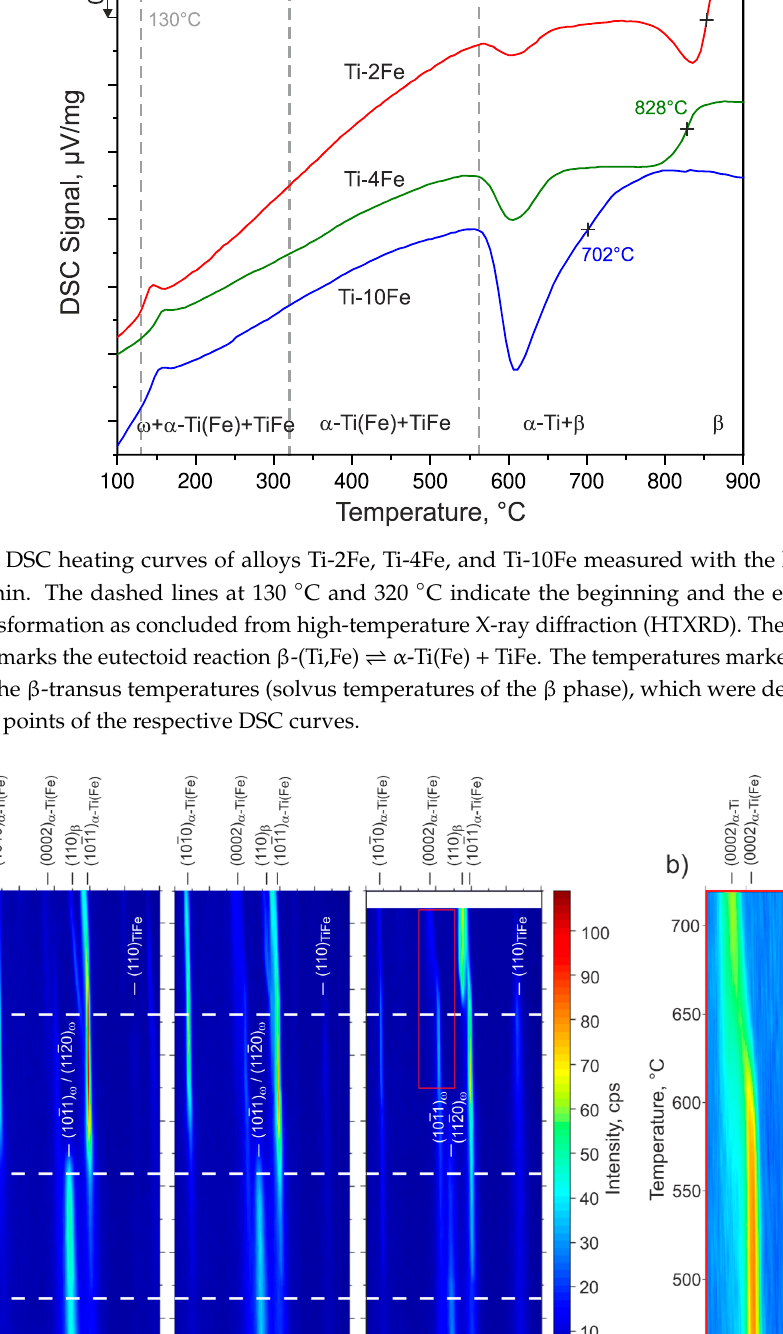
Figure 5. Low-angle part of the HTXRD patterns of Ti-2Fe, Ti-4Fe, and Ti-10Fe that were originally annealed for 4000 h at 470 °C and subjected to HPT. The positions of diffraction lines originating from phases α -Ti(Fe), β , ω and TiFe are indicated by markers at the top or inside the figures. The temperature axes of the HTXRD measurements were calibrated according to the DSC measurements as described in the text. The dashed lines in ( a ) indicate the transformation temperatures upon heating from Figure 4. ( b ) illustrates the change of the 0002 line position in Ti-10Fe (see inset in ( a )) at high temperatures.